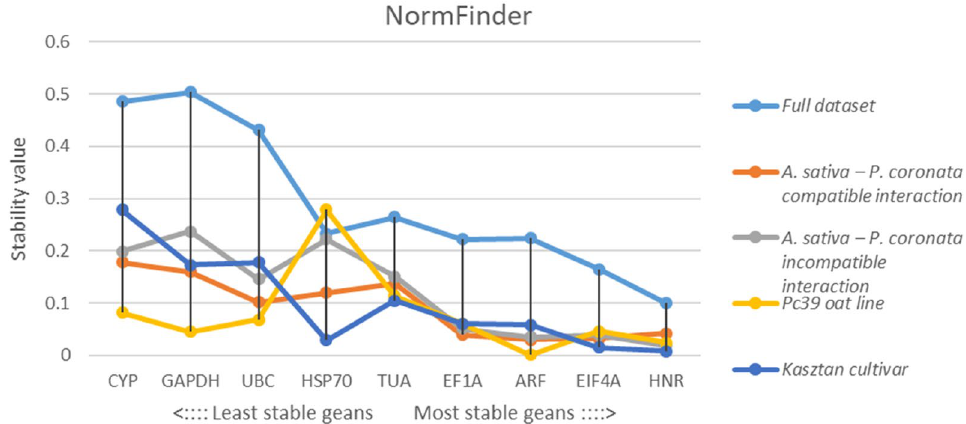
Figure 3. Stability values (SV) of tested RGs determined by NormFinder algorithm for full dataset, compatible interaction dataset, incompatible interaction dataset, Pc39 oat line dataset and Kasztan cultivar dataset. Low SV values indicate high expression stability across samples set.